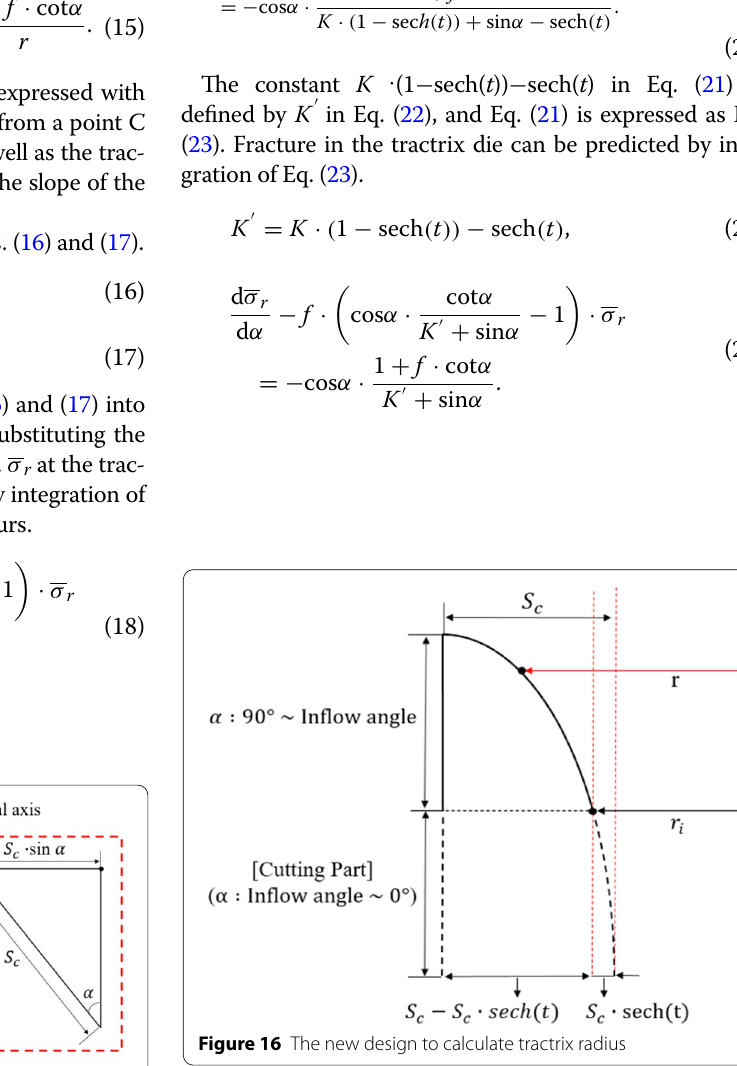
Figure 15 Tractrix curve expressed with radius